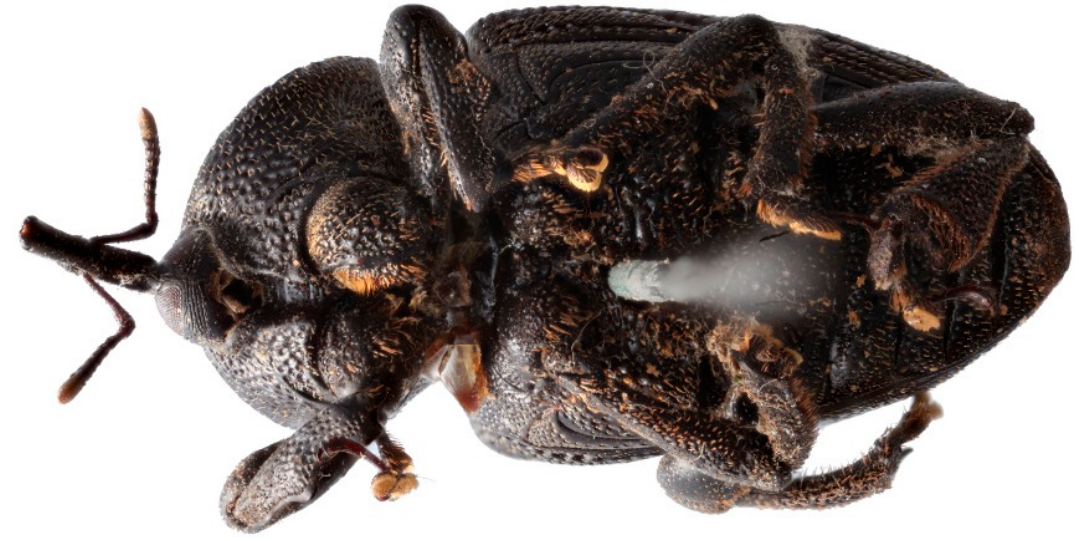
Figure 5. Sclerocardius africanus (Boheman): lectotype, ventral. Photographed by Gunvi Lindberg (© 2018 Naturhistoriska riksmuseet). Original photo cropped, light levels and contrast adjusted. Made available by the Swedish Museum of Natural History under Creative Commons Attribution 4.0